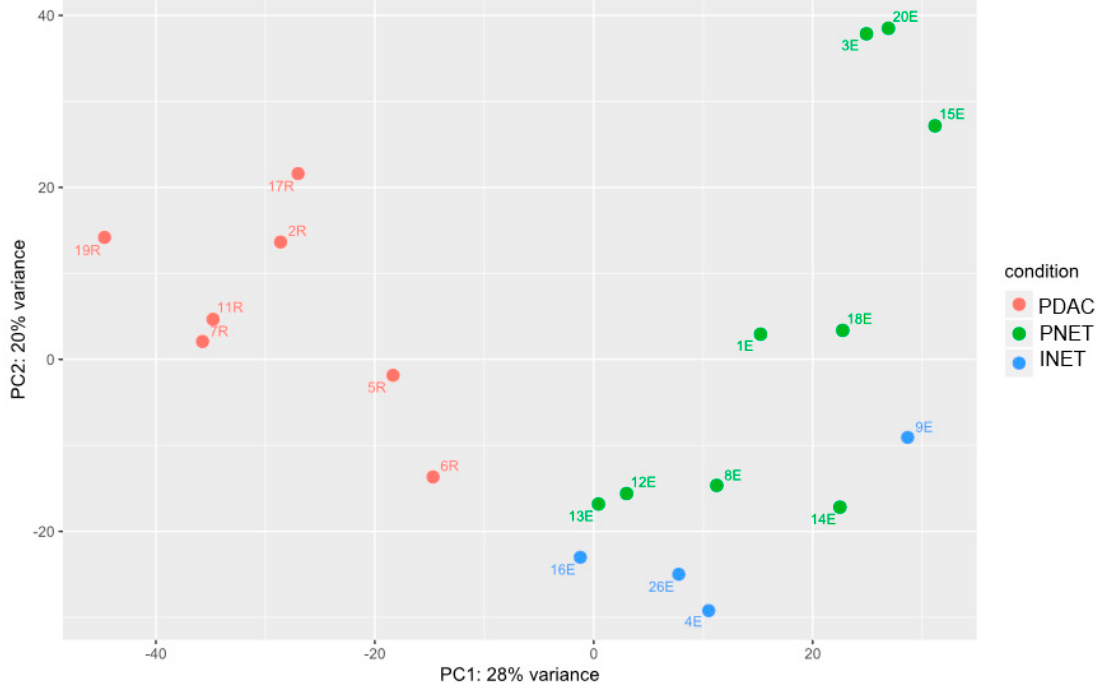
Figure 3. Deep sequencing of the mRNA transcriptomes identified 2082, 2621, and 107 mRNAs, whose expression significantly differentiated between PDACs and PNETs, PDACs and INETS, and PNETs and INETs, respectively, as demonstrated by principal component analysis (PCA) using the DESeq2 function “plotPCA” with the default parameters.